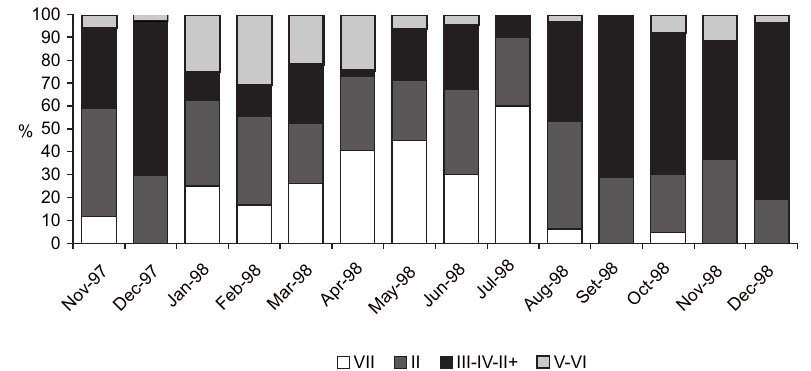
Fig . 7. – Catalan Sea. Monthly percentages of females in different maturity stages during sampling period.